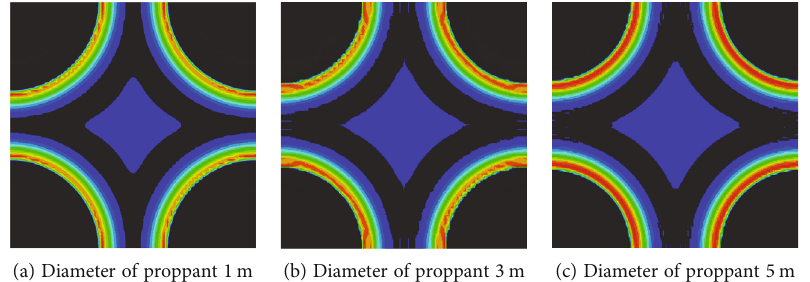
Figure 42: Contact stress cloud diagram of rock slab under di ff erent proppant